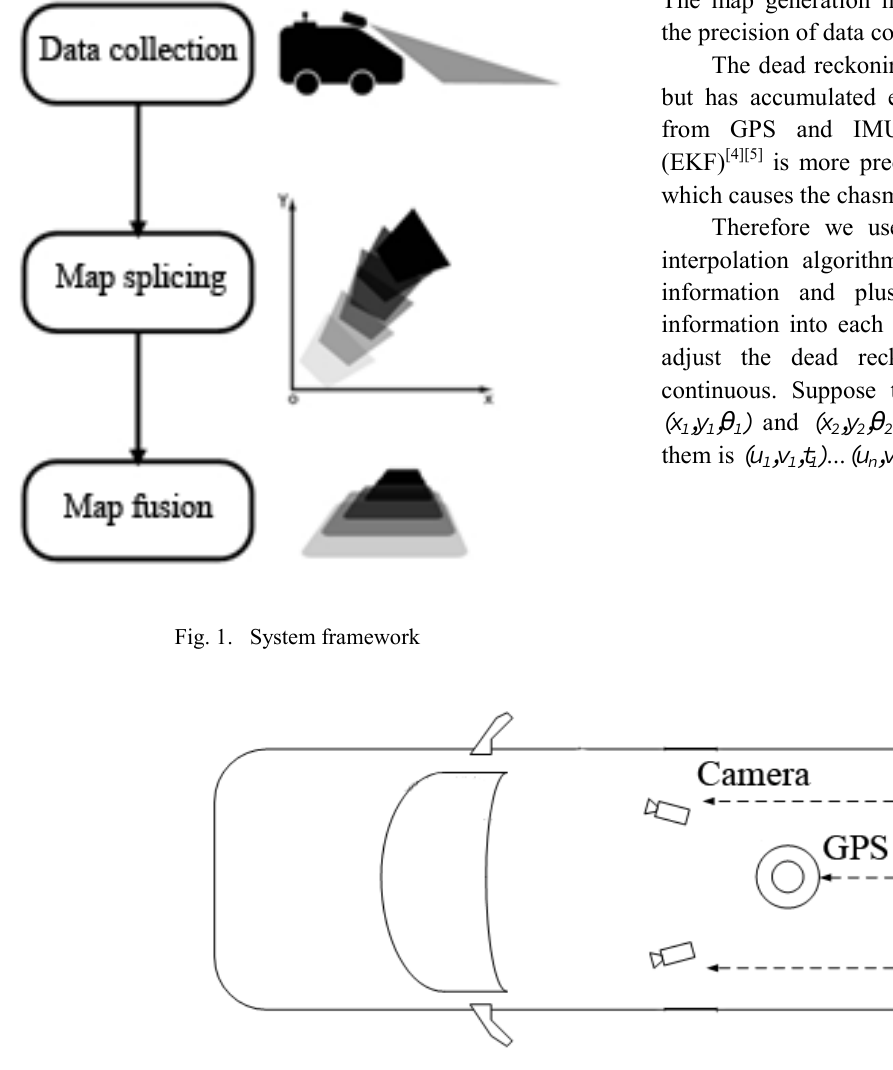
Fig.2. Sensor configuration of the data collection